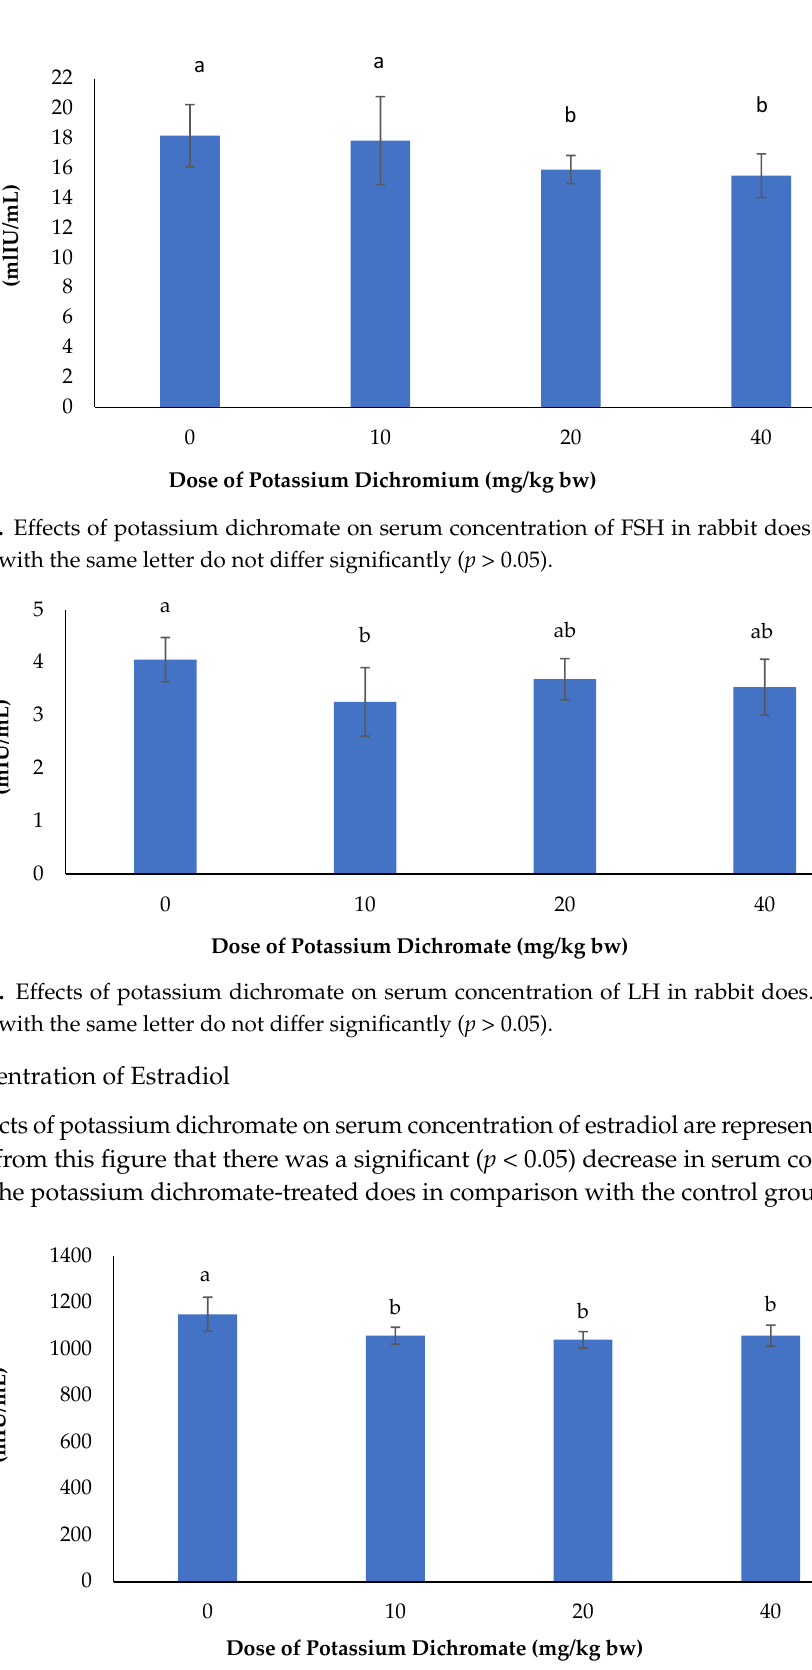
Figure 4. Effects of potassium dichromate on serum concentration of estradiol in rabbit does. a,b: bars affected with the same letter do not differ significantly ( p > 0.05).